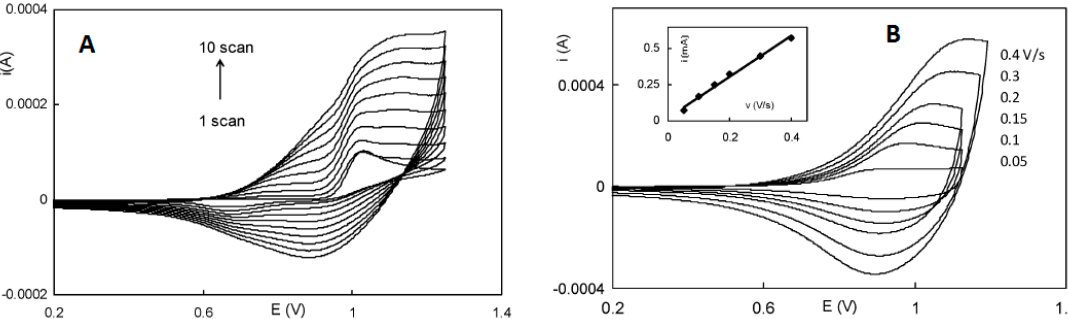
Figure 1. ( A ) The 10 scan electrochemical oxidation of terth-Ala-OMe (2) in ACN. (B ) poly2-Pt at different scan rates. Reprinted with permission from reference [43]. Copyright 2010 The Royal Society of Chemistry.